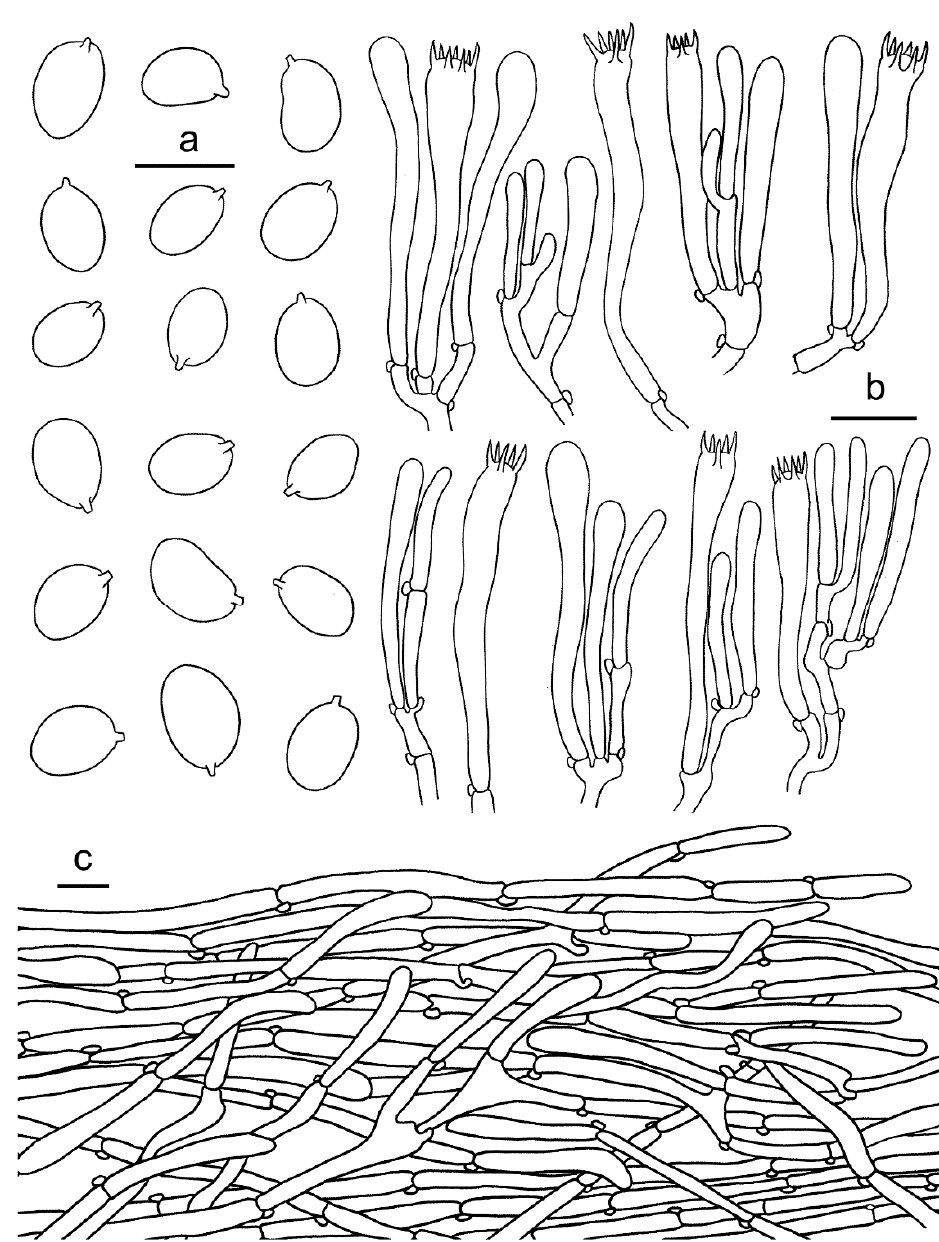
Figure 14. Cantharellus zangii (GDGM83193). ( a ) Basidiospores. ( b ) Basidia, basidiola and elements of the subhymenium. ( c ) Pileipellis. Bars: ( a ) = 10 µ m; ( b , c ) = 20 µ m. Basidiomata small-sized. Pileus 10–40 mm broad, convex when young, then applanate with center depressed at mature, surface dry, brown to dark brown (6E6–7E6, 6F6–7F6) at first, gradually fading to light brown to brownish orange (5C5–6C5, 5D5–6D5), glabrous, irregularly wrinkled, hygrophanous when wet, margin incurved and irregularly wavy. Hymenophore decurrent, subdistant, gill like, well developed, ridges 1.5–2 mm, composed of bifurcate and interconnected low veins, in particular toward pileus margin, veins usually less than 1 mm broad between ridges, light yellow (3A5), olive yellow (3C6), greyish yellow (4B6) to pale orange (5A4). Stipe 50–130 × 3–6 mm, subcylindrical, or gradually broader towards base, central, hollow, mostly twisted or longitudinally ridged or fluted, surface smooth, slightly waxy, brownish orange (5C5) to light orange (6A5) on upper half, greyish yellow (4B5) on lower half. Context 1–3 mm thick, greyish yellowish to olive brown (4B4–4D4), unchanging when bruised. Odour pleasant. Taste